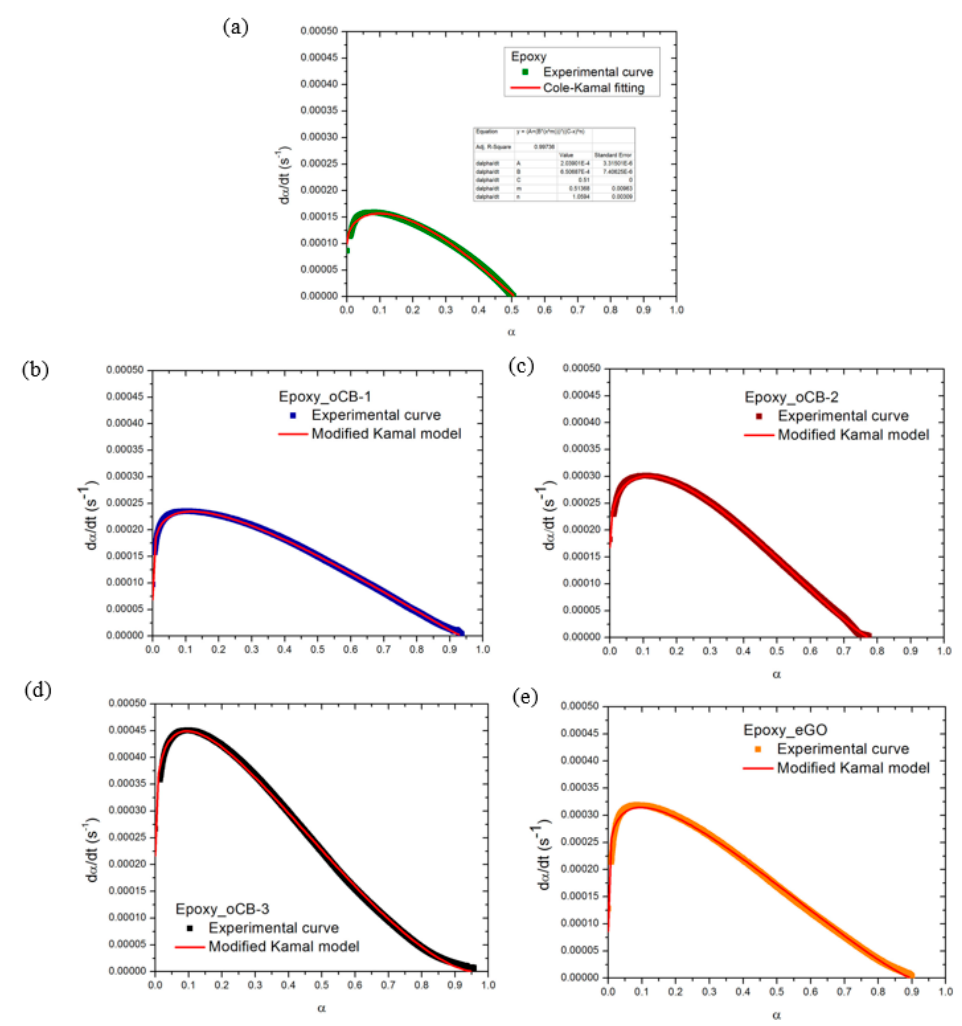
Figure 8. Comparison between Equation (6) model predictions and the experimental data of epoxy resins ( a ) filled by 3 wt % of different nanofillers; ( b ) oCB-1 (O/C, wt/wt = 0.16); ( c ) oCB-2 (O/C, wt/wt = 0.83); ( d ) oCB-3 (O/C, wt/wt = 0.91); ( e ) eGO (O/C, wt/wt = 0.62). wt/wt = 0.83); ( d ) oCB-3 (O/C, wt/wt = 0.91); ( e ) eGO (O/C, wt/wt =